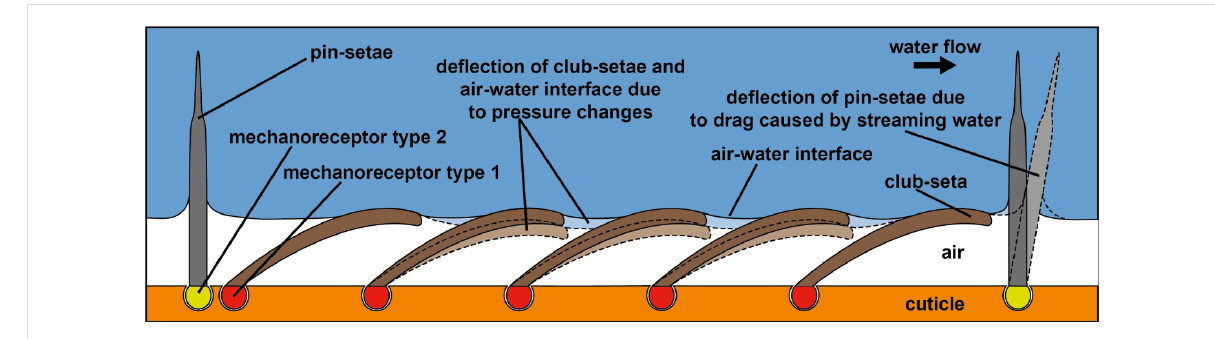
Figure 7: Proposed Notonecta forewing surface function. An air layer is kept in between the setae. The club-setae (dark brown) support the air–water interface. If pressure increases, the air is compressed and the air–water interface is deformed. This deflects the seta (light brown, dashed outline). Mechanoreceptors (red) connected with the cuticle (orange) at the base of each seta should enable monitoring of the setal deflection. The pins (dark gray) most likely penetrate the air–water interface. If so they should be deflected (light gray, dashed outline) by water flow. This deflection most likely is sensed by cuticular mechanoreceptors (yellow).